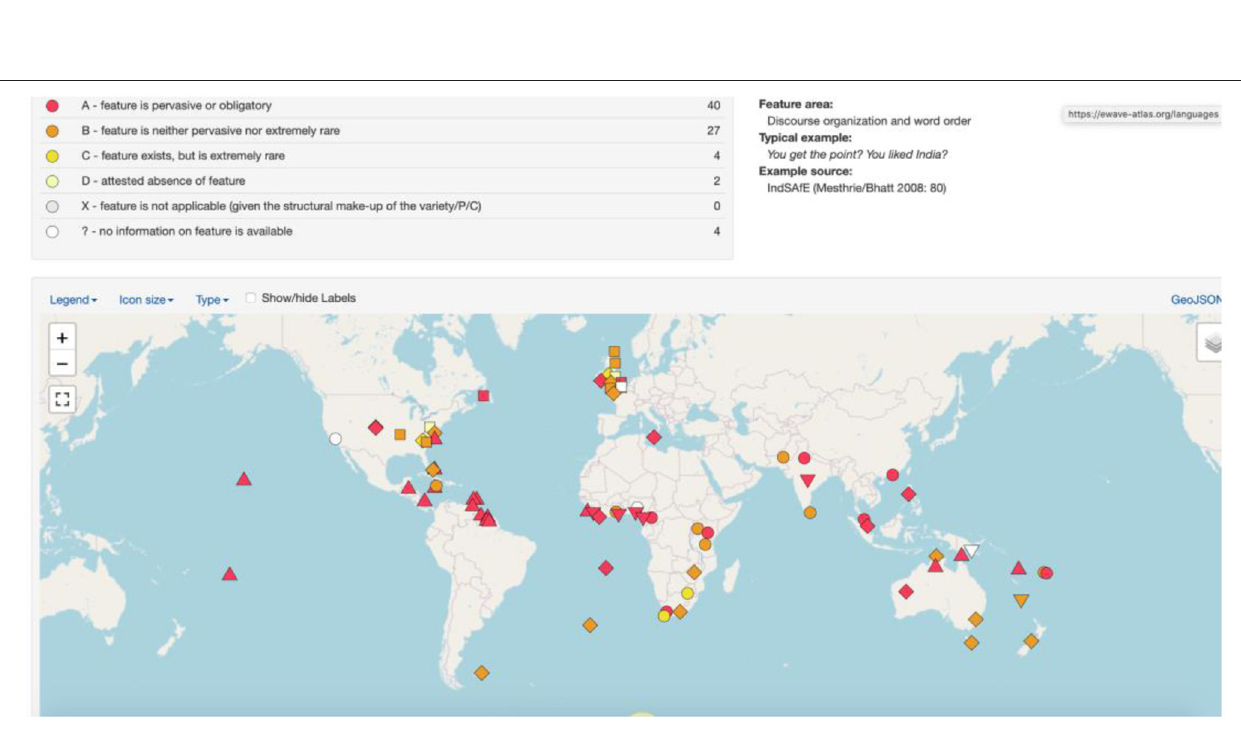
Frontiers in Communication |